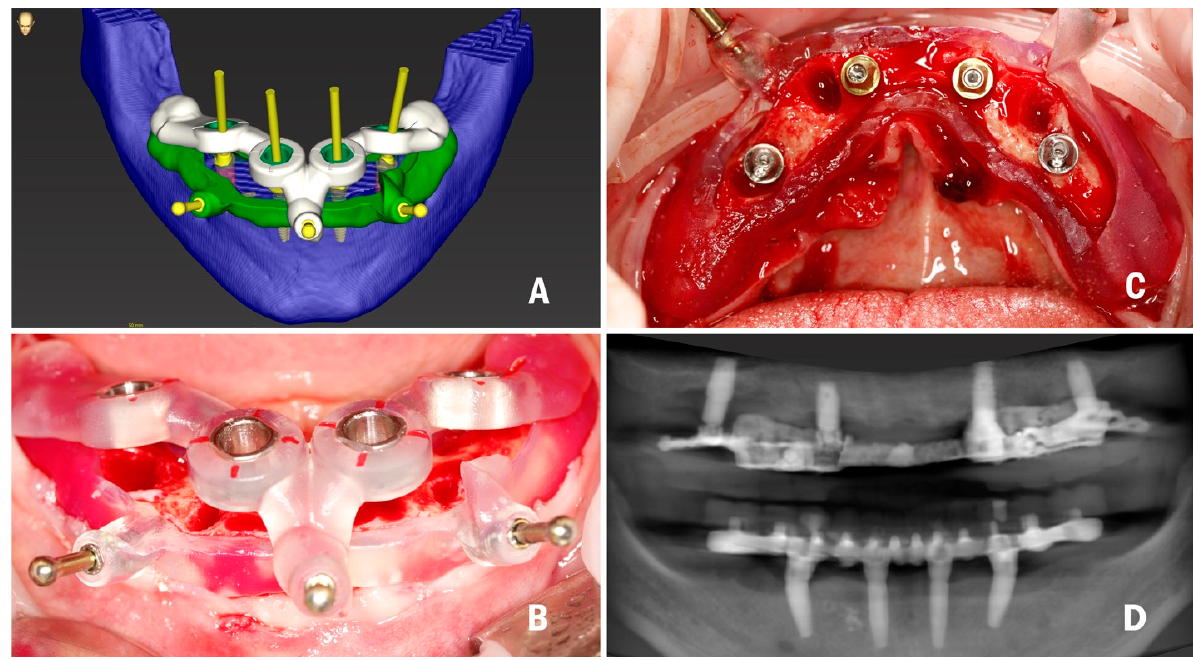
Figure 1. ( A ) Computer-assisted implant planning; ( B ) Implant placement surgery; ( C ) Implants and SRA in situ; and ( D ) Postoperative CBCT.